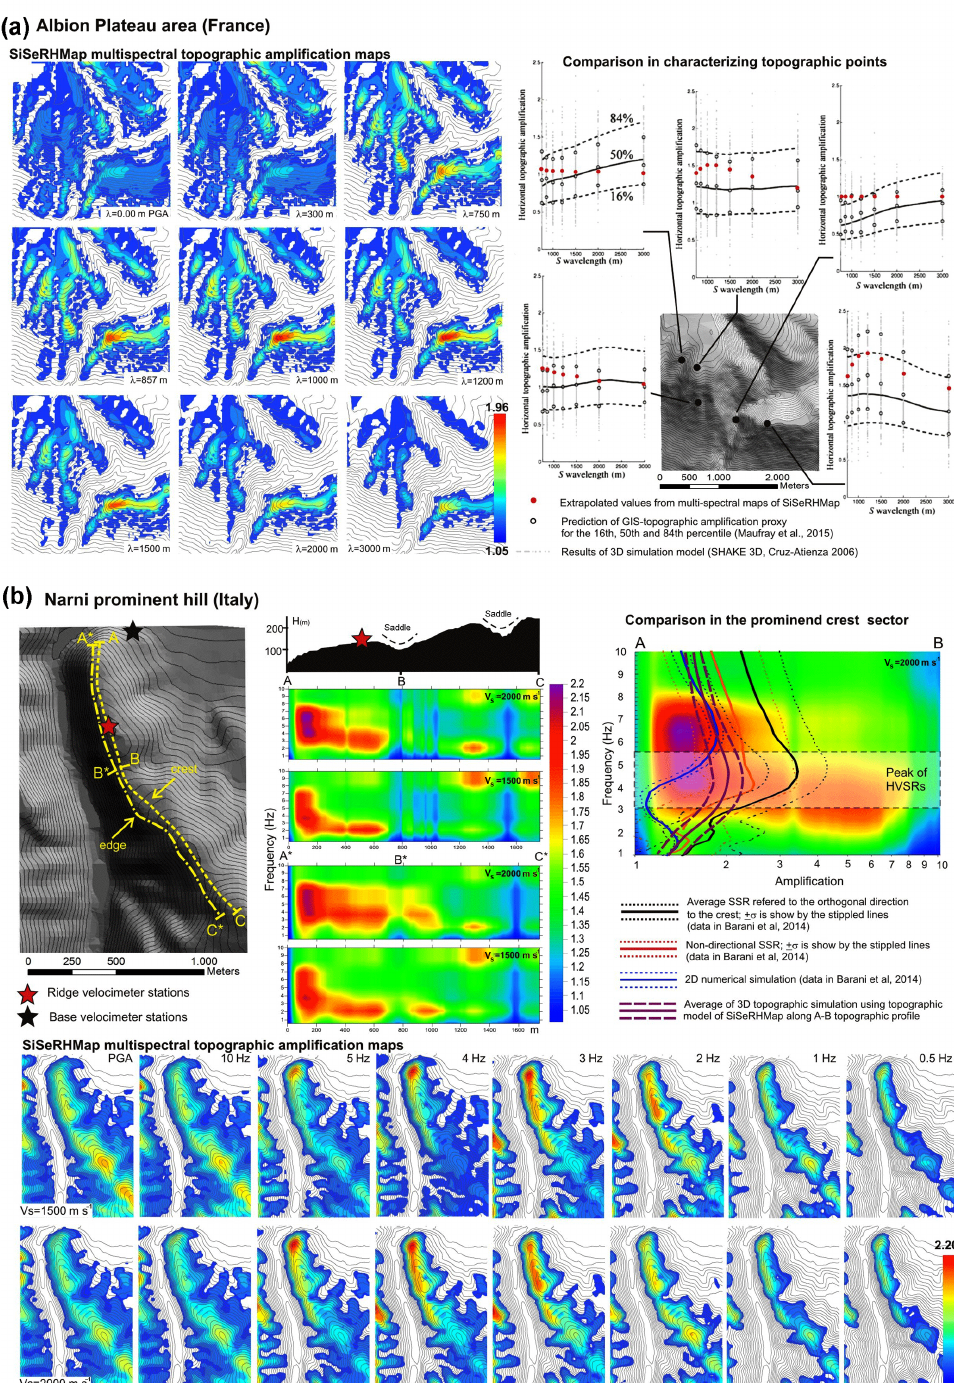
Figure 13. (a) Albino Plateau area (France): SiSeRHMap multi-spectral topographic amplification maps shown in terms of wavelength, λ , assuming a V S of 3000ms − 1 and using a resolution in elevation of 20m. Comparison in characterizing topographic points between the map-extrapolated values and the results of 3-D simulation model (SHAKE 3D; Cruz-Atienza 2006); results of GIS-topographic amplification proxy, which is built and calibrated in this specific area (Maufroy et al., 2015). (b) Narni prominent hill (Italy): SiSeRHMap multi-spectral topographic amplification maps defined assuming V S of 1500 and 2000ms − 1 ; performance of the model along the edge and crest profile. Comparison analysis referring to a sector of the crest profile ( A – B ) with results of the experimental and 2-D numerical simulation model (Massa et al., 2010; Barani et al.,